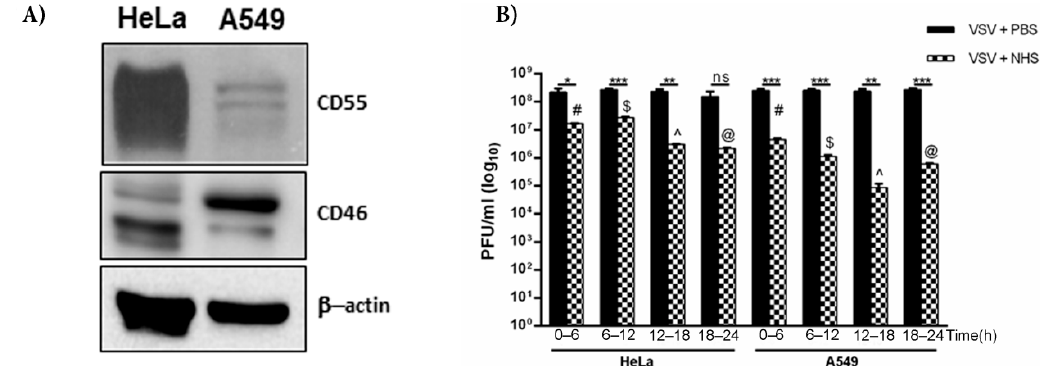
Figure 6. CD55 confers greater resistance to VSV against complement compared to CD46. ( A ) Western blot depicting the level of expression of CD55 and CD46 in HeLa and A549 cells; β -actin served as the equal loading control. ( B ) The effect of NHS in neutralizing VSV grown in HeLa and A549 cells was assessed by a plaque reduction assay. The virus harvested at the indicated time intervals was incubated either with NHS or PBS (black bars). At all of the time points tested, the HeLa-grown viruses showed marked resistance to complement-mediated neutralization. The degree of neutralization of A549-grown VSV known to harbor less CD55 was significantly higher than that of HeLa-grown VSV at 12–18 h ( p < 0.0001). The symbols in the graph represent * p < 0.05; ** p < 0.005; *** p < 0.0005). The additional symbols represent the comparison of significance between A549- and HeLa-grown VSV treated with NHS at the respective time ranges, where # p < 0.0005; $ p < 0.0005; ^ p < 0.0001; @ p < 0.005. Table 3. Comparison of the neutralization of VSV grown in two different cell lines that express varying levels of RCAs. Serial Number